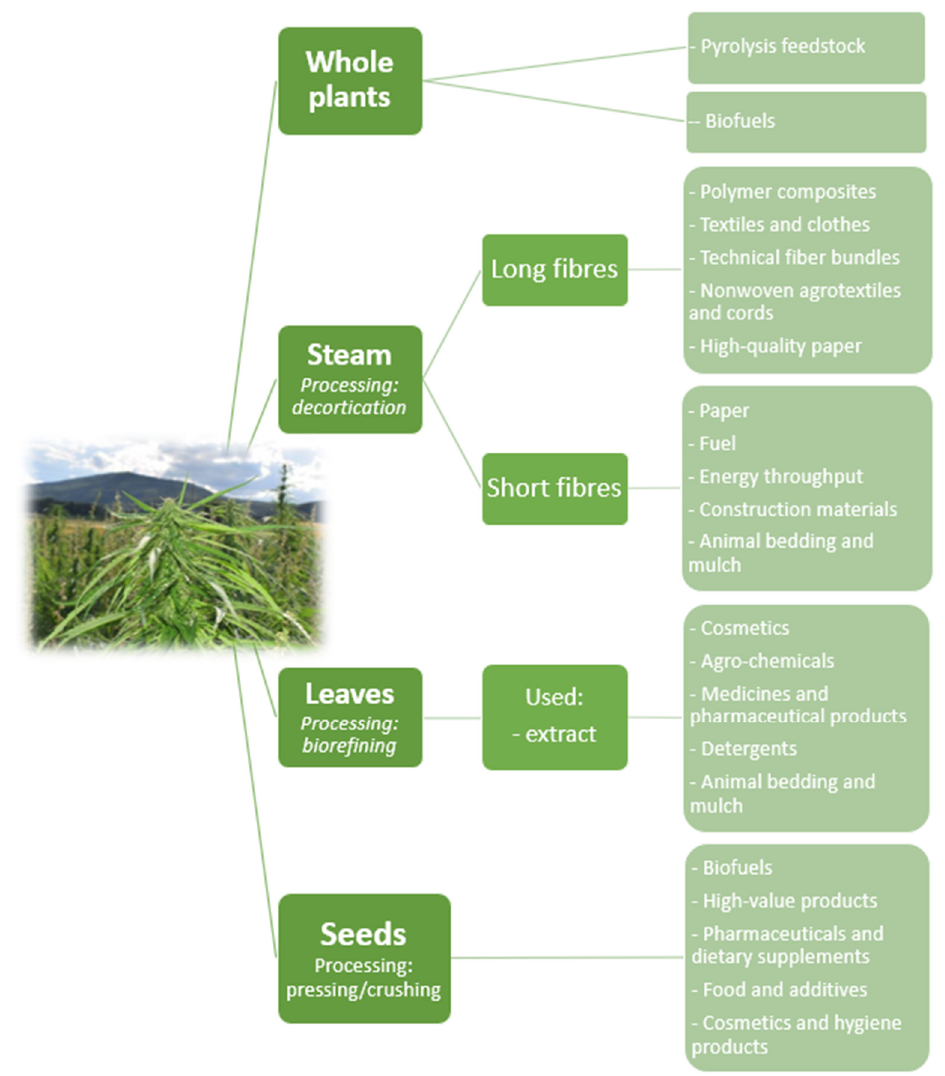
Figure 6. The use of hemp in various industries due to the division into the parts of the plant